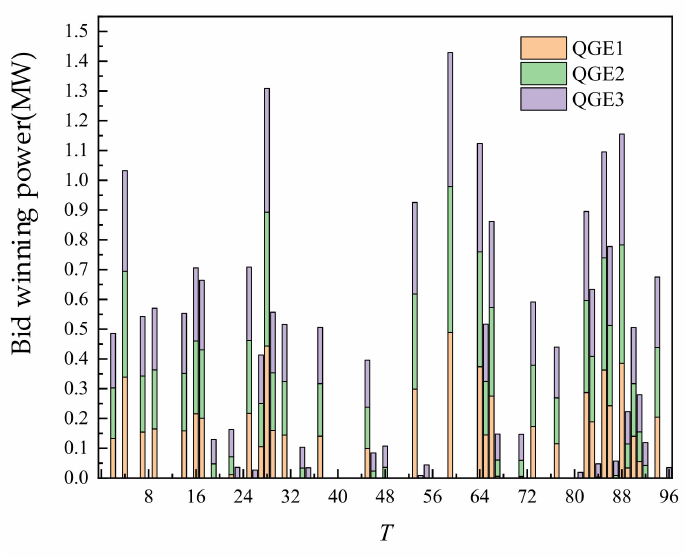
Figure 16. Intra-day trading of thermal power units.